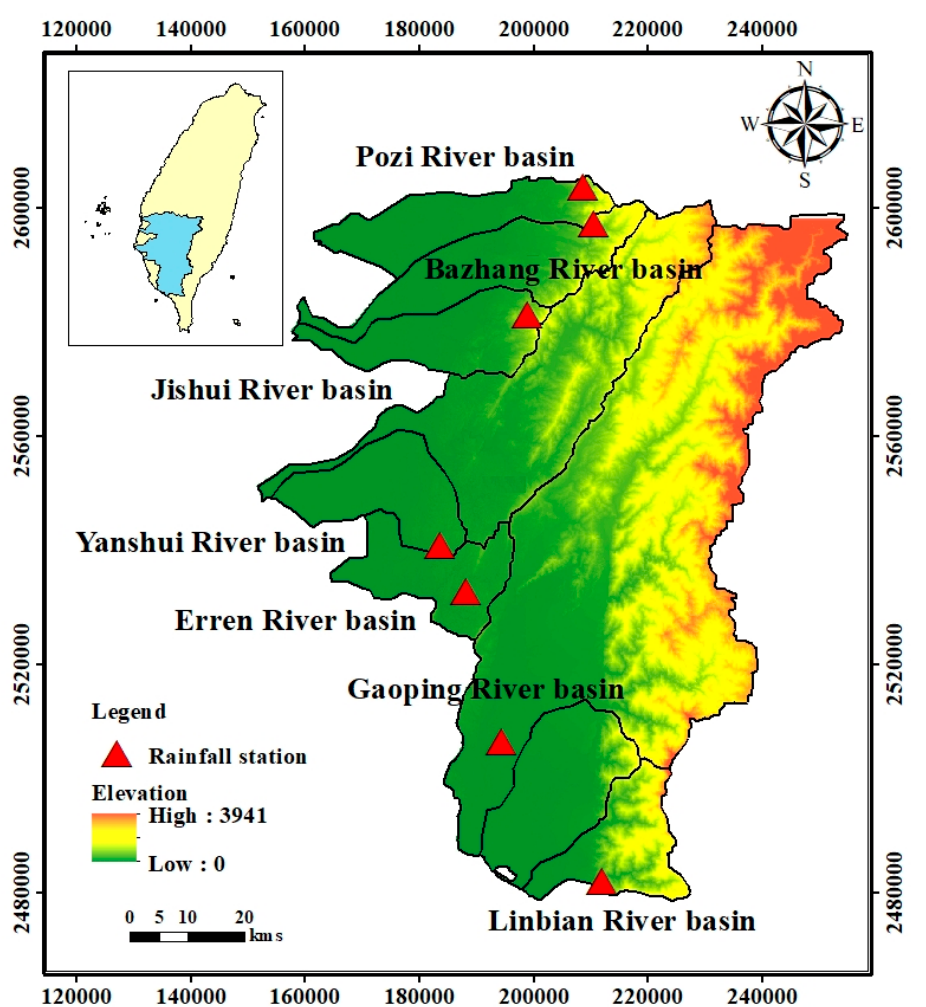
Figure 1. Spatial distribution of the elevation and rainfall stations at each basin.